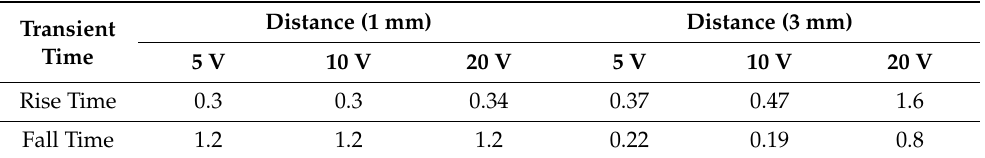
Table 3. Transient time of the photocurrent at different voltages of Ga 2 O 3 on quartz under the presence of Ag catalyst with different distances of the metal contacts: 1 mm and 3 mm.